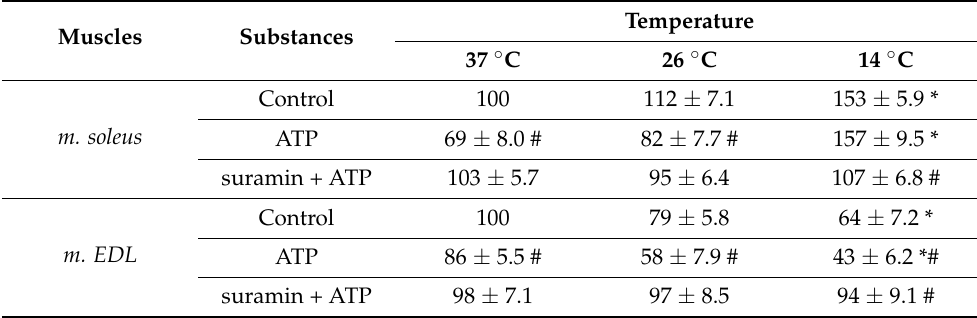
Table 1. Effect of ATP (100 µ M) and suramin (100 µ M) on the contraction force of the tetanic Table 1 . Effect of ATP (100 µM) and suramin (100 µM) on the contraction force of the tetanic contraction (in %) of m. soleus ( A ) and m. EDL ( B ) under different temperature regimes (n = 8). * p < contraction (in %) of m. soleus (A) and m. EDL (B) under different temperature regimes ( n = 8). 0.05 from the effect at 37 °C, # p < 0.05 from control). * p < 0.05 from the effect at 37 ◦ C, # p < 0.05 from control).